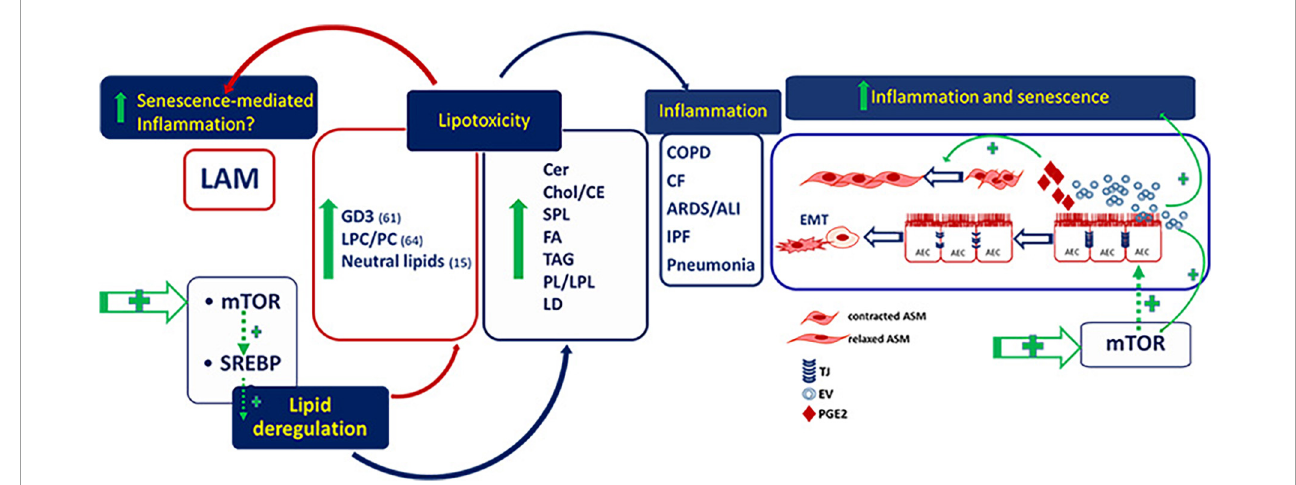
FIGURE1 Deregulated lipids in lymphangioleiomyomatosis (LAM) and pulmonary diseases. GD3, ganglioside D3; LPC/PC, lysophosphatidylcholine/ phosphatidylcholine; Cer, ceramide; Chol/CE, cholesterol/cholesterol esthers; SPL, sphingolipids; FA, fatty acids; TAG, riacylglycerols; PL/LPL, phospholipids/lysophospholipids; LD, lipid droplets; AEC, alveolar epithelial cells; ASM, airway smooth